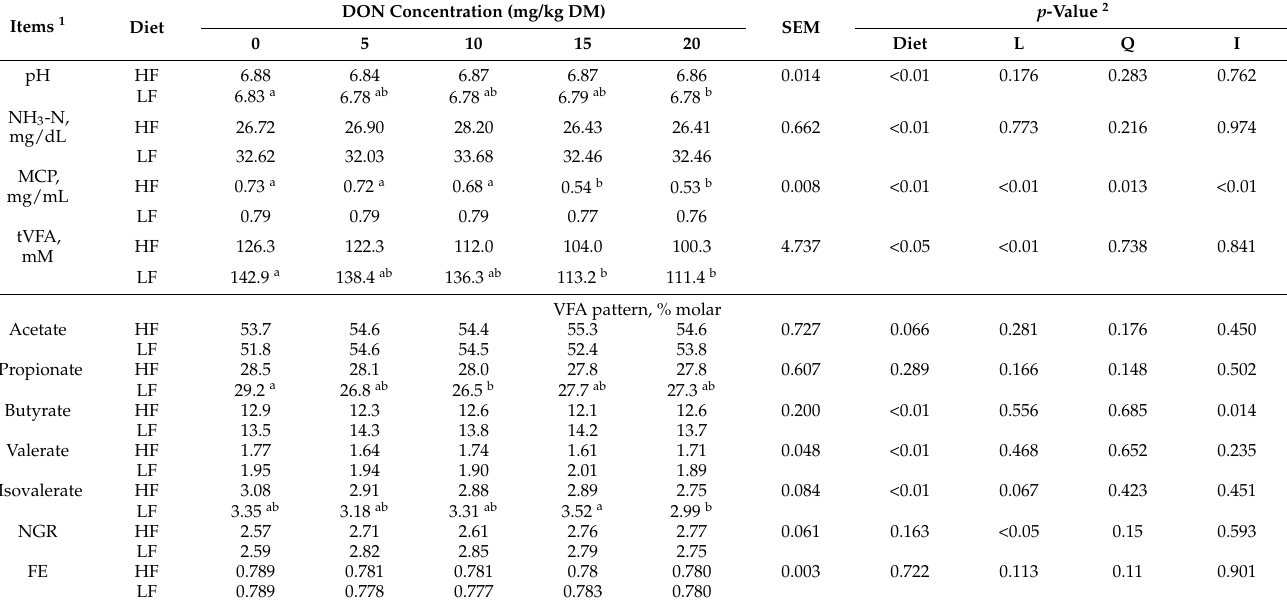
Table 5. Effect of DON concentration (mg/kg DM) on pH, ammonia nitrogen (NH 3 -N), microbial crude protein (MCP) and volatile fatty acid (VFA) production in fermentation fluids after 48 h incu- bation.